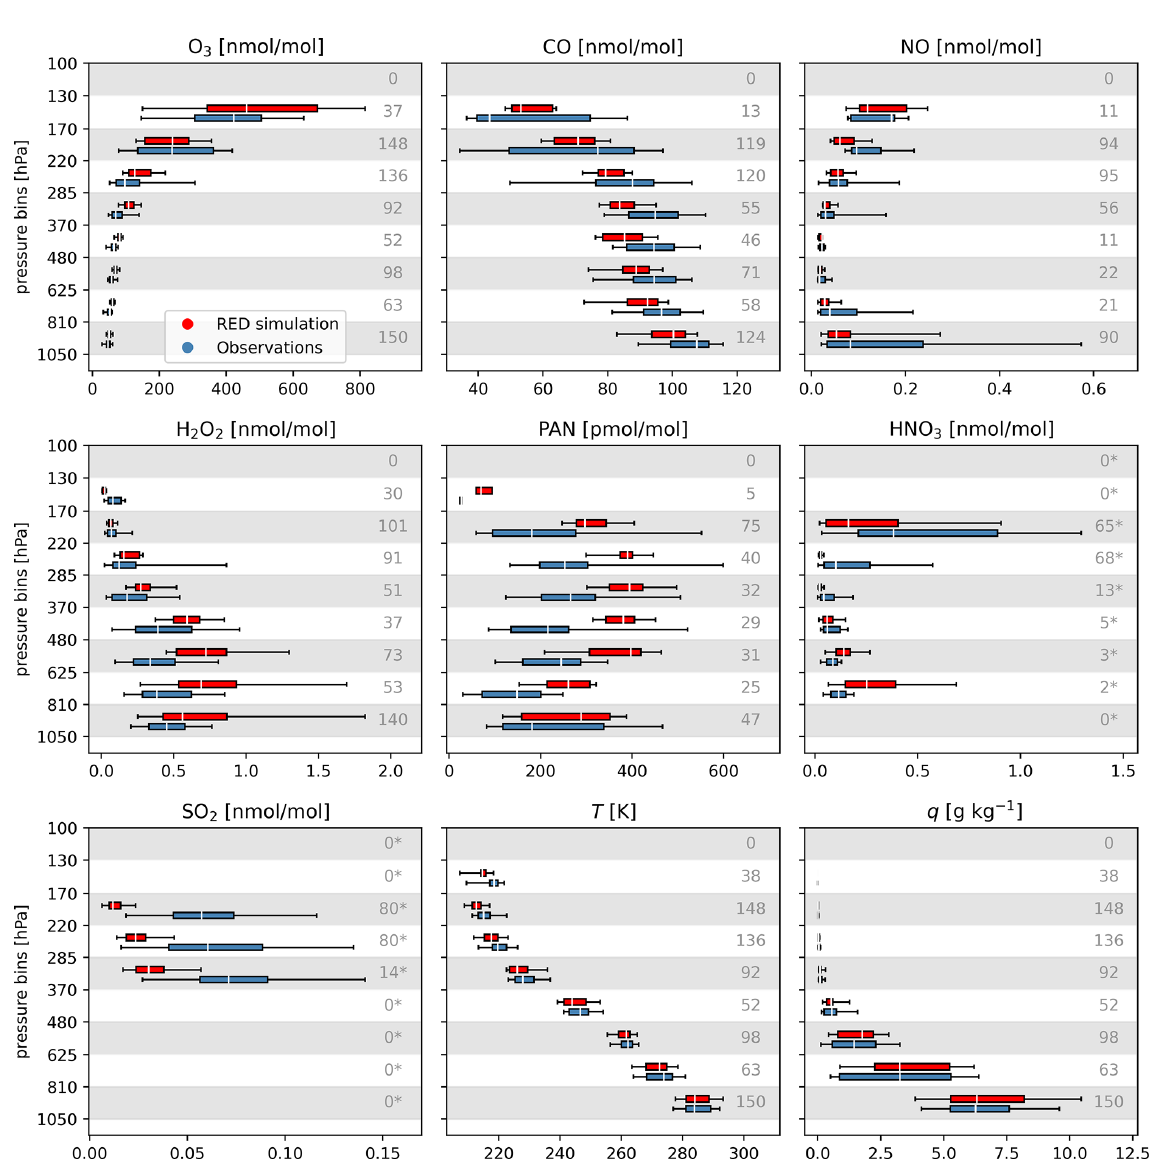
Figure 2. Vertical distribution of simulated (red, simulation RED) and observed (blue) tracer mixing ratios and two meteorological variables ( T and q ), represented by box–whisker plots for pressure bins. The white line marks the median, the box corresponds to lower and upper quartiles, the whiskers represent the 5th–95th percentile. The grey numbers on the right indicate the sample size (number of observed and interpolated simulated data points) for each pressure bin. Simulated values are from the RED simulation, i.e., with reduced emissions and no aerosol–cloud interactions. For HNO 3 and SO 2 (measured onboard the Falcon aircraft, shown by the grey number marked with asterisks) the domain average of the model results over Europe at the corresponding altitude were used, not the values sampled online on the flight